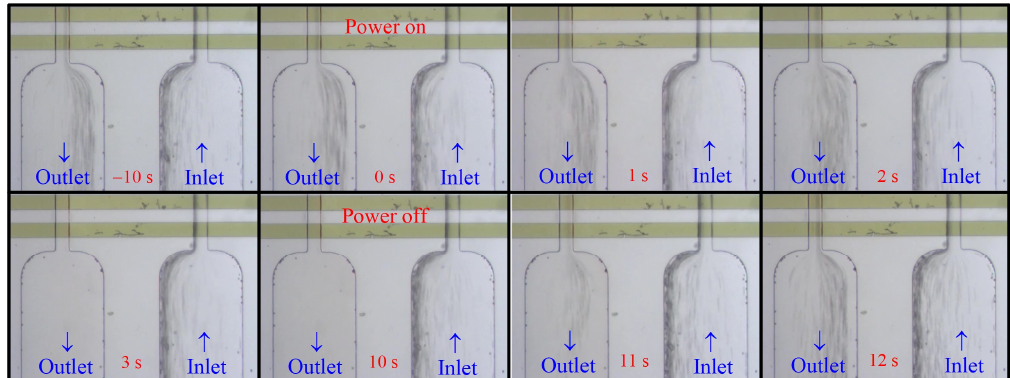
Figure 3. Snapshots at different time instants from Video S1 for case B1 in Table 1 (2 V 0 = 20 V pp , a = 50 µ m, Q = 50 µ L / hr, bell-shape inlet / outlet). No cells were observed (completely lysed) in the outlet region from 3 s to 10 s after the power of the electrodes had been turned on for 3 s, and it clearly shows electrical cell lysis.